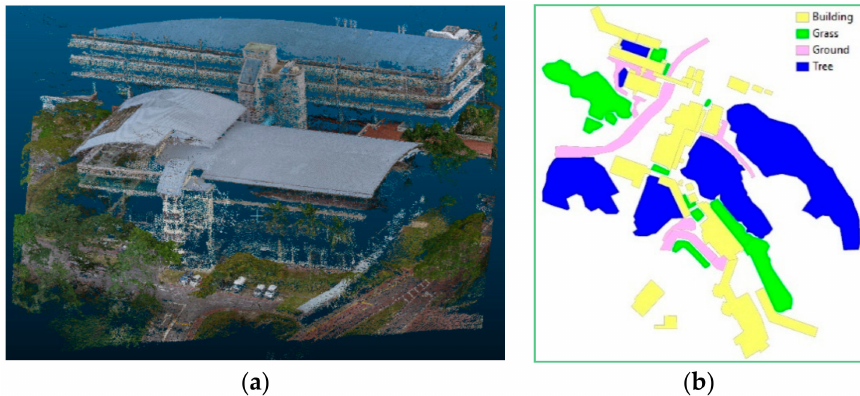
Figure 3. ( a ) Light Detection and Ranging (LiDAR) point cloud; ( b ) 2D land cover map, and Dataset1 consisting of the computer center and central library of the National University of Singapore (NUS).